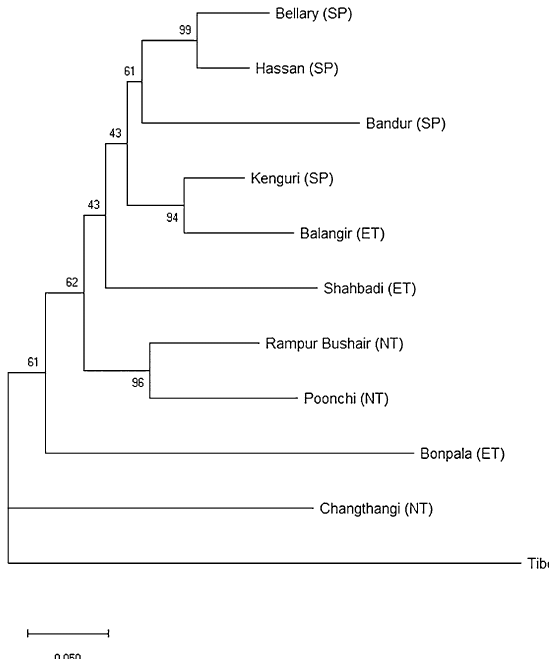
Figure 3. Neighbour Joining (NJ) dendrogram based on pair-wise Da distance using MEGA 6 42 (https ://www. megas oftwa re.net/). Values at nodes indicate percent bootstrap (1000)